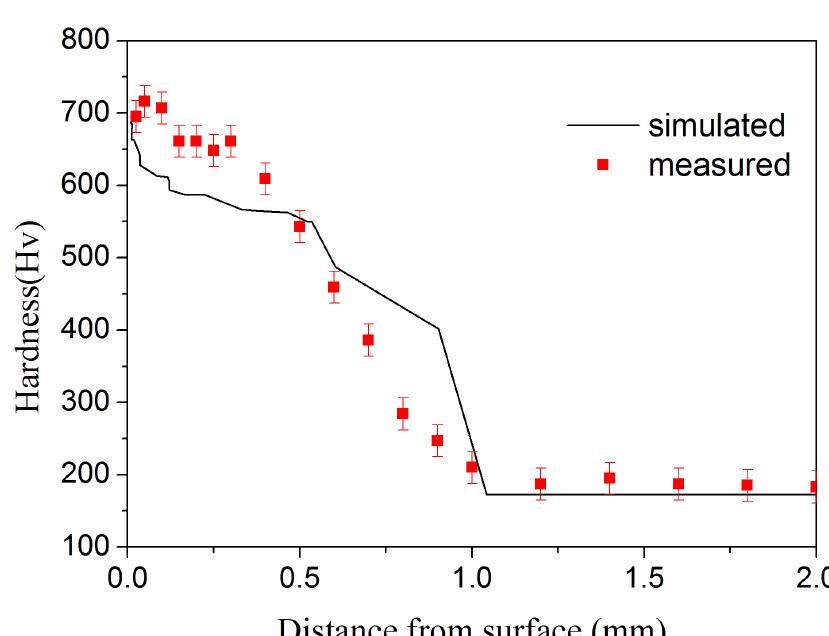
Fig. 6 Hardness distributions in SCr420H